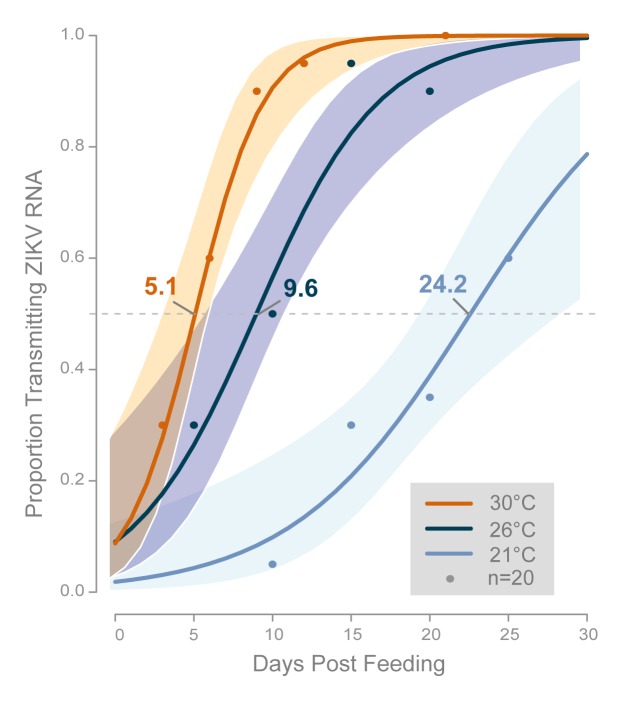
Fitted logistic curves showing the proportions of Ae. aegypti transmitting ZIKV vRNA over time by temperature.Each point represents the observed proportion of mosquitoes (of 20 tested) that transmitted at each temperature and time-point. The estimated EIP50 is indicated for each temperature.